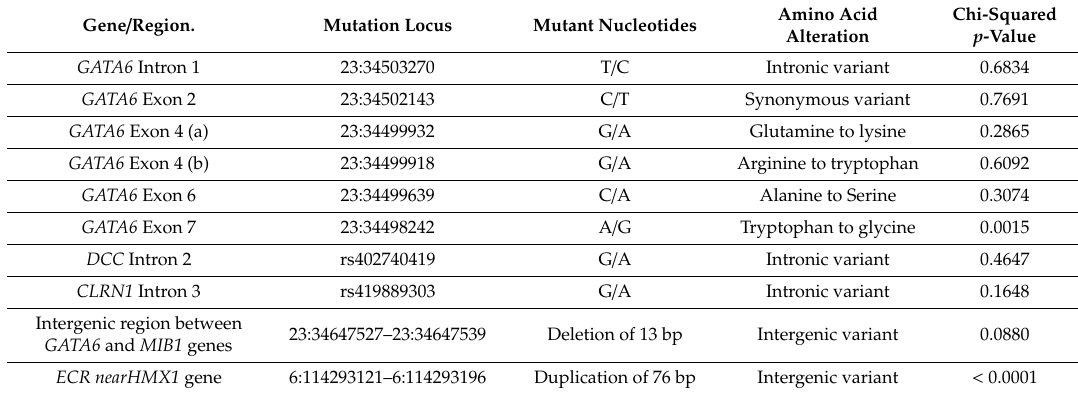
Table 2. Summary of detected mutations within targeted genomic loci.